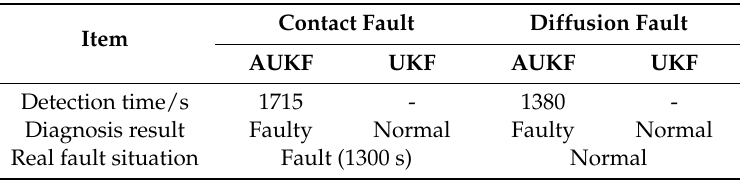
Table 4. Diagnosis result of Parameter Abrupt-Type Fault.